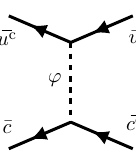
Figure 1 . Tree-level diagram mediated by a color-sextet scalar contributing to D 0 - ¯ D 0 mixing. (Diagram is drawn with external color-conjugate quarks to show correct flow of fermion number; this process is equivalent to u ¯ c → ¯ uc